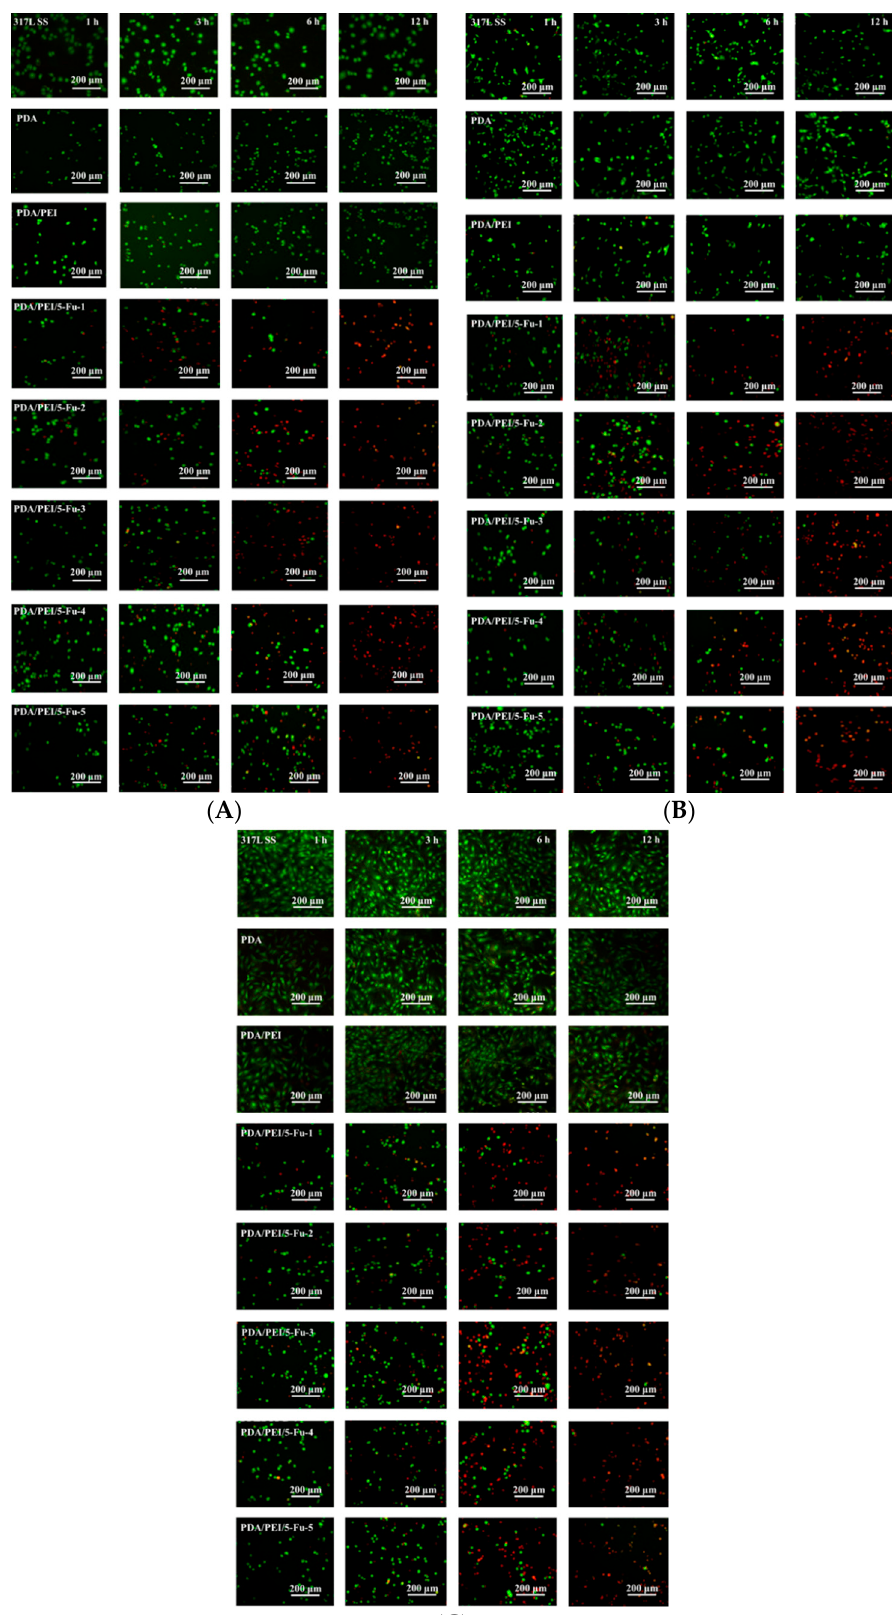
Figure 6. ( A ) Eca109, ( B ) Het-1A and ( C ) L929 cells apoptosis and necrosis influenced by the 5-Fu released from the PDA/PEI/5-Fu layers and reference surfaces (green intact nucleus: vital cells; dense green areas of chromatin condensation in the nucleus: early apoptosis; dense orange areas of chromatin condensation: late apoptosis; orange intact nucleus: secondary necrosis).